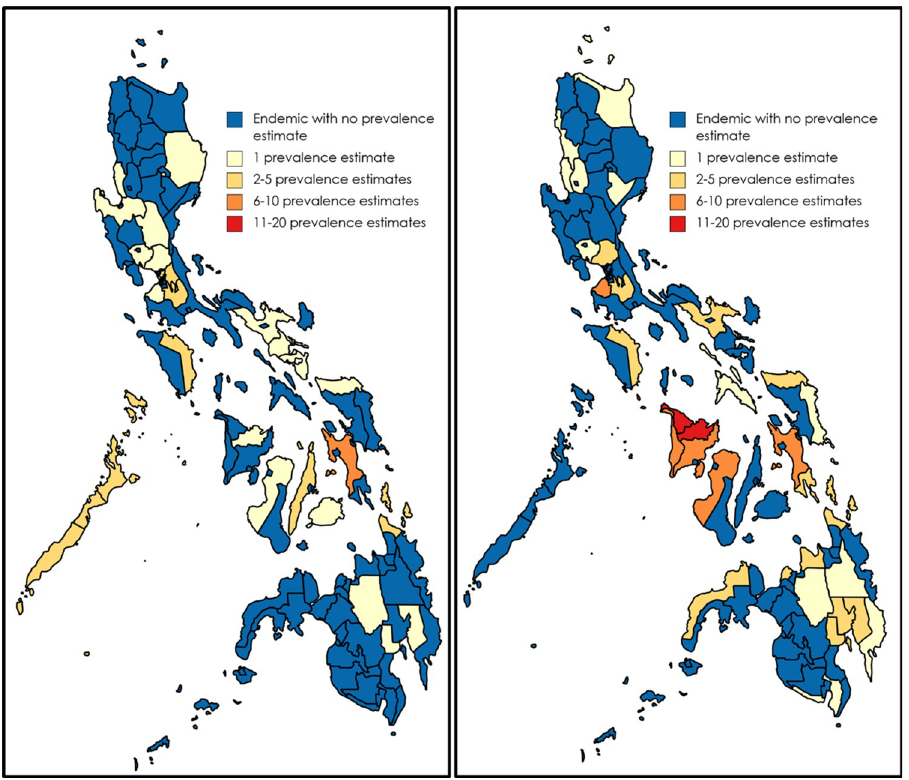
Fig 2. Sites of STH prevalence estimates pre-(left) and post-preventive chemotherapy (right) initiation. Created using MapChart (https://mapchart.net/index.html